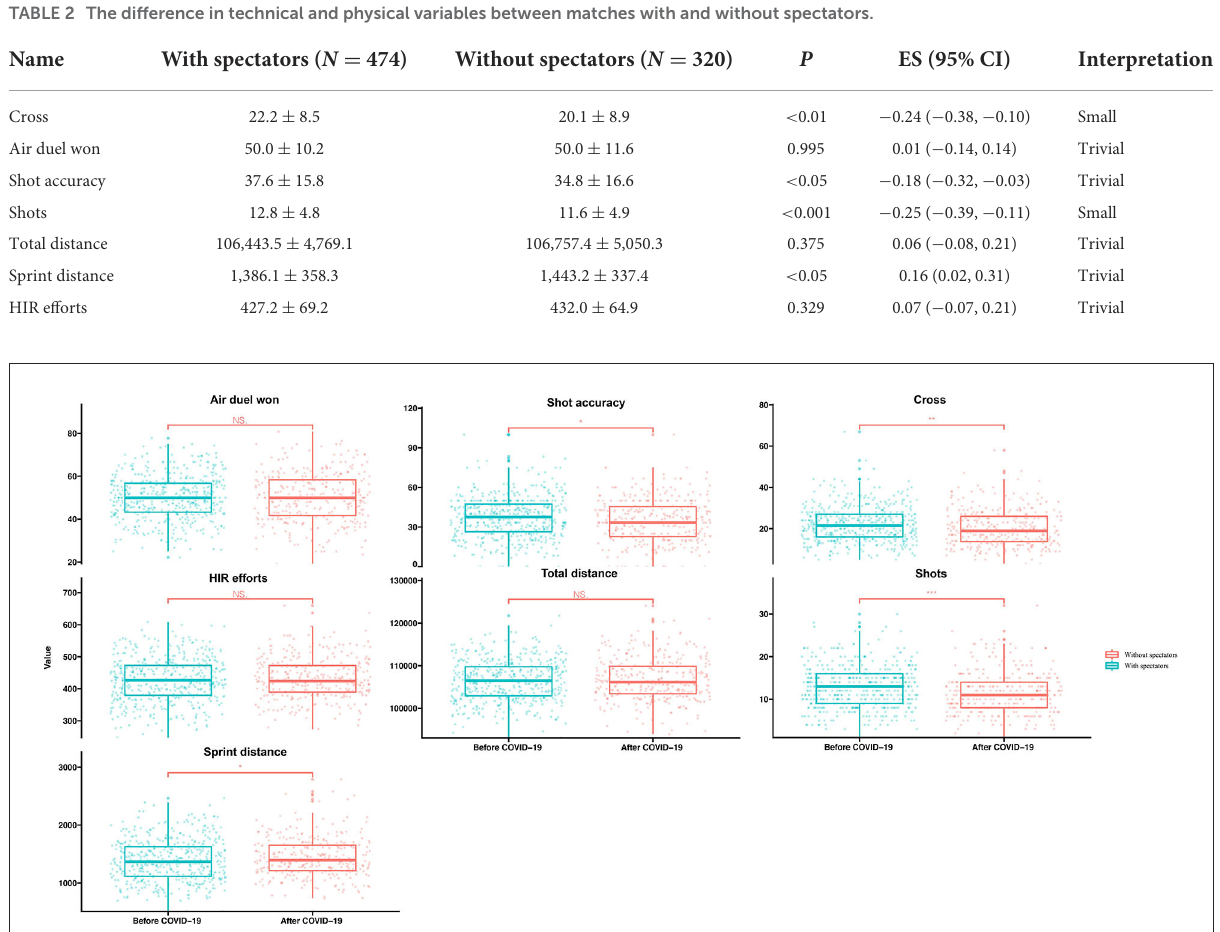
FIGURE2 The visualization of the difference in technical and physical variables between matches with and without spectators. Note: * p < 0.05, ** p < 0.01, *** p < 0.001. NS. means no statistical significance.